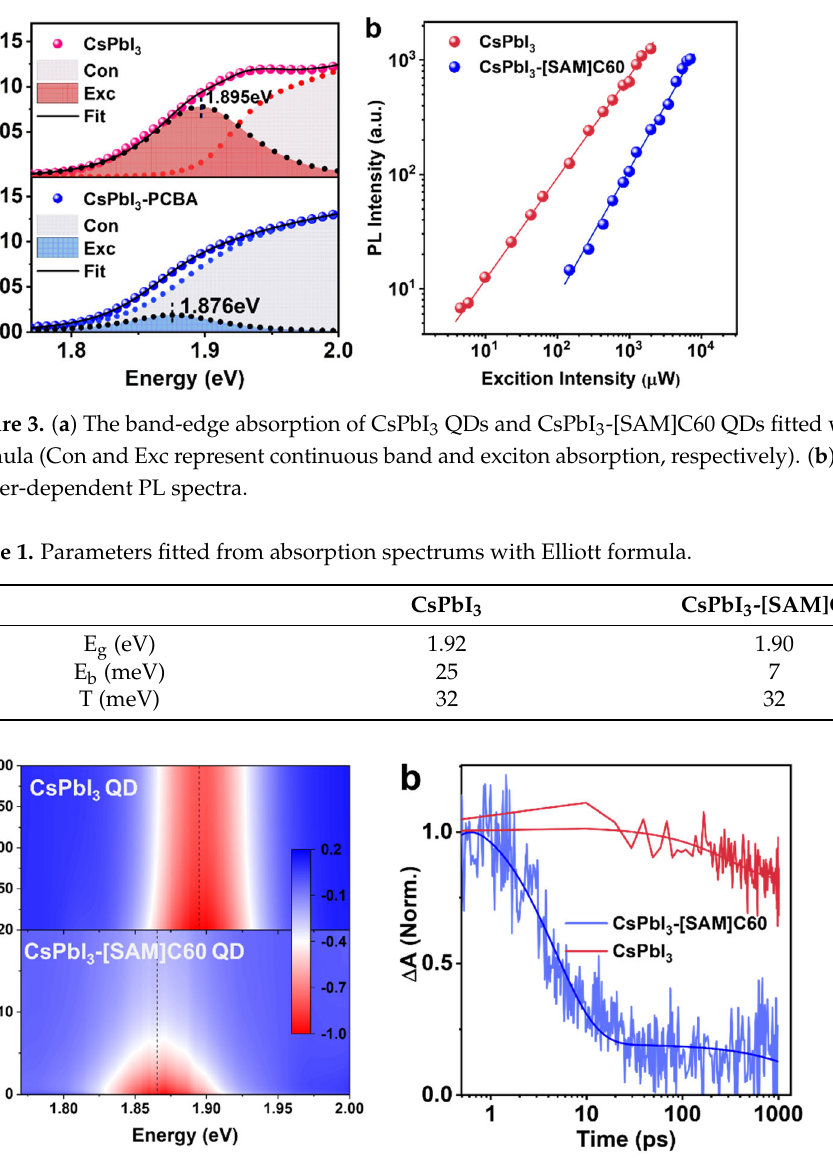
Figure 4. ( a ) Pseudo-color TA maps of CsPbI 3 QD and CsPbI 3 -[SAM]C60 QD under a 600 nm of excitation wavelength, 16 µ J/cm 2 of pump fluence. ( b ) Bleaching dynamics for CsPbI 3 QD and CsPbI 3 -[SAM]C60 QD,